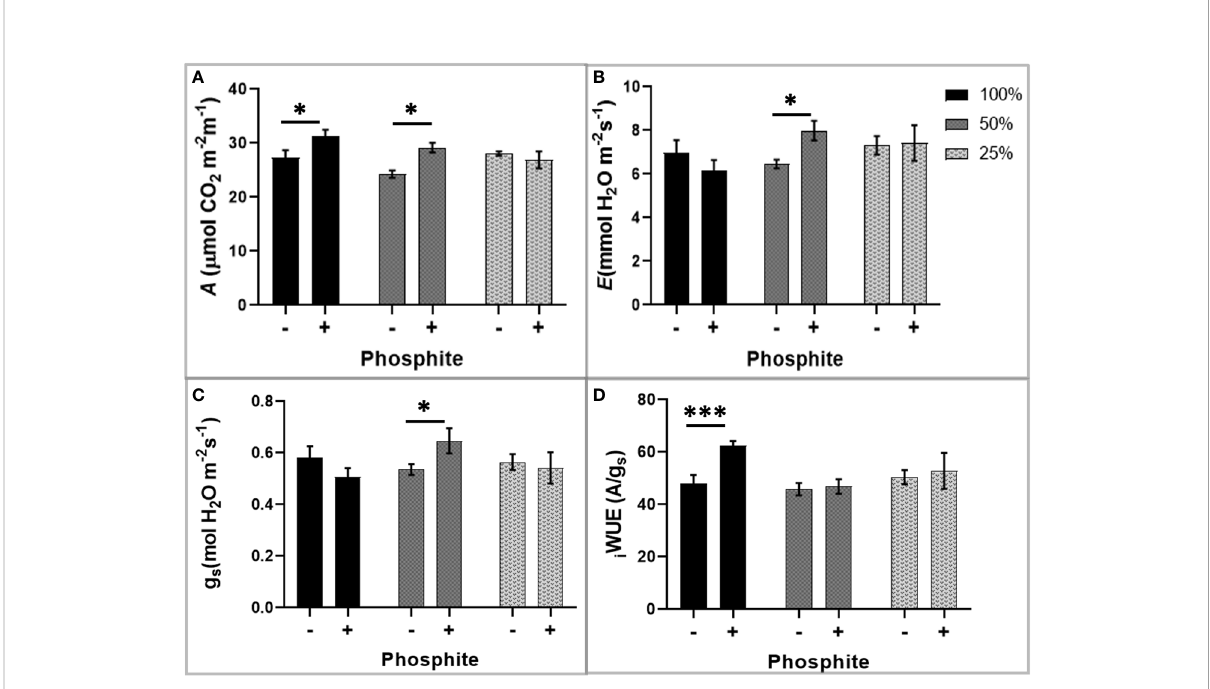
FIGURE 4 Phosphite treatment improves carbon assimilation under mild nutrient stress. Photosynthetic response of phosphite treated (+) and untreated (-) wheat plants grown under different nutrient strength of a commercial soluble fertilizer (NPK: 20-8-20). (A) Net carbon assimilation rate (B) Transpiration rate (C) Stomatal conductance (D) Intrinsic water use ef fi ciency from a ratio of net photosynthesis to stomatal conductance. All values are means ± SE (n=6); *indicates signi fi cant difference (student ’ s t test P ≤ 0.05). ***P ≤